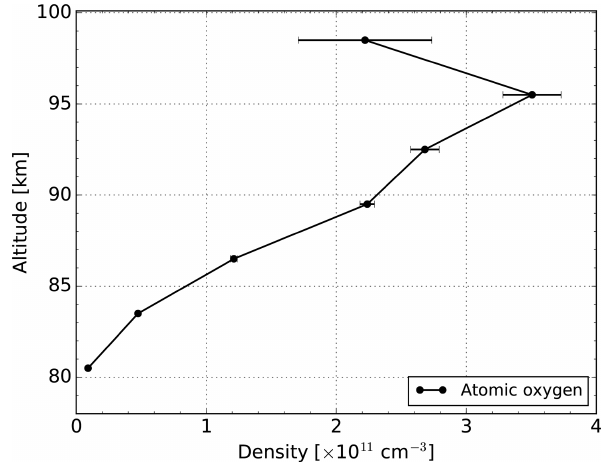
Figure 6. Atomic oxygen abundances, derived from GOMOS monthly zonal mean measurements of OH(8–4) airglow emissions for February 2006 at 10–20 ◦ N. The error bar represents the statisti- cal uncertainty coming from the measurement noise. It increases to- wards higher altitudes as a consequence of the corresponding SNR being